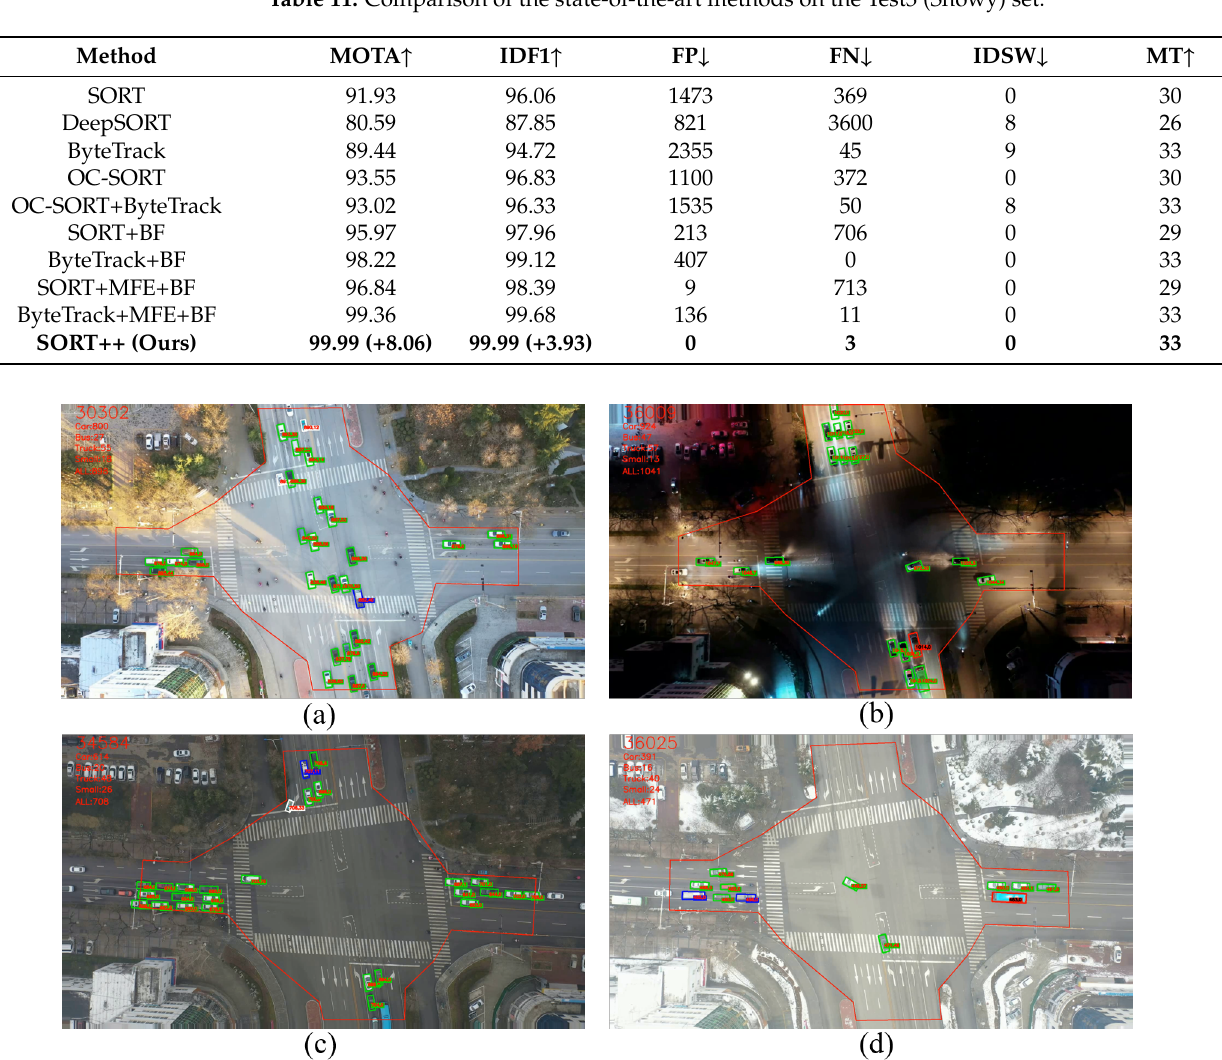
Table 11. Comparison of the state-of-the-art methods on the Test3 (Snowy) set.